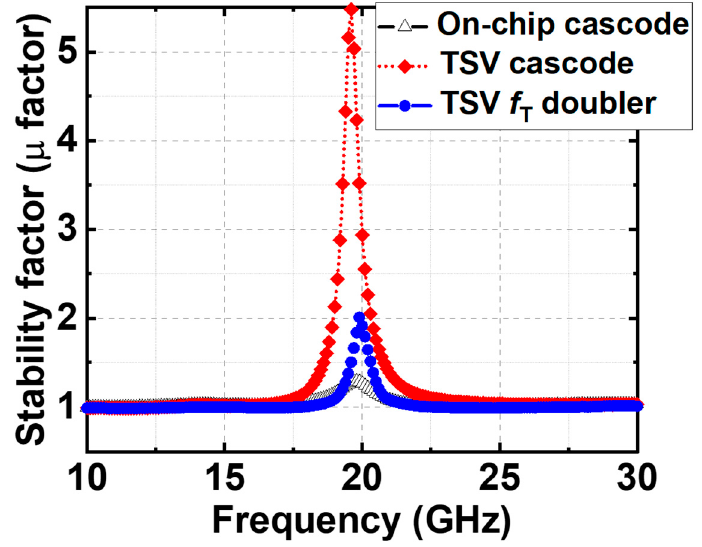
Figure 6. Stability factor (µ factor) of the proposed f T -doubler and conventional cascode RFAs.